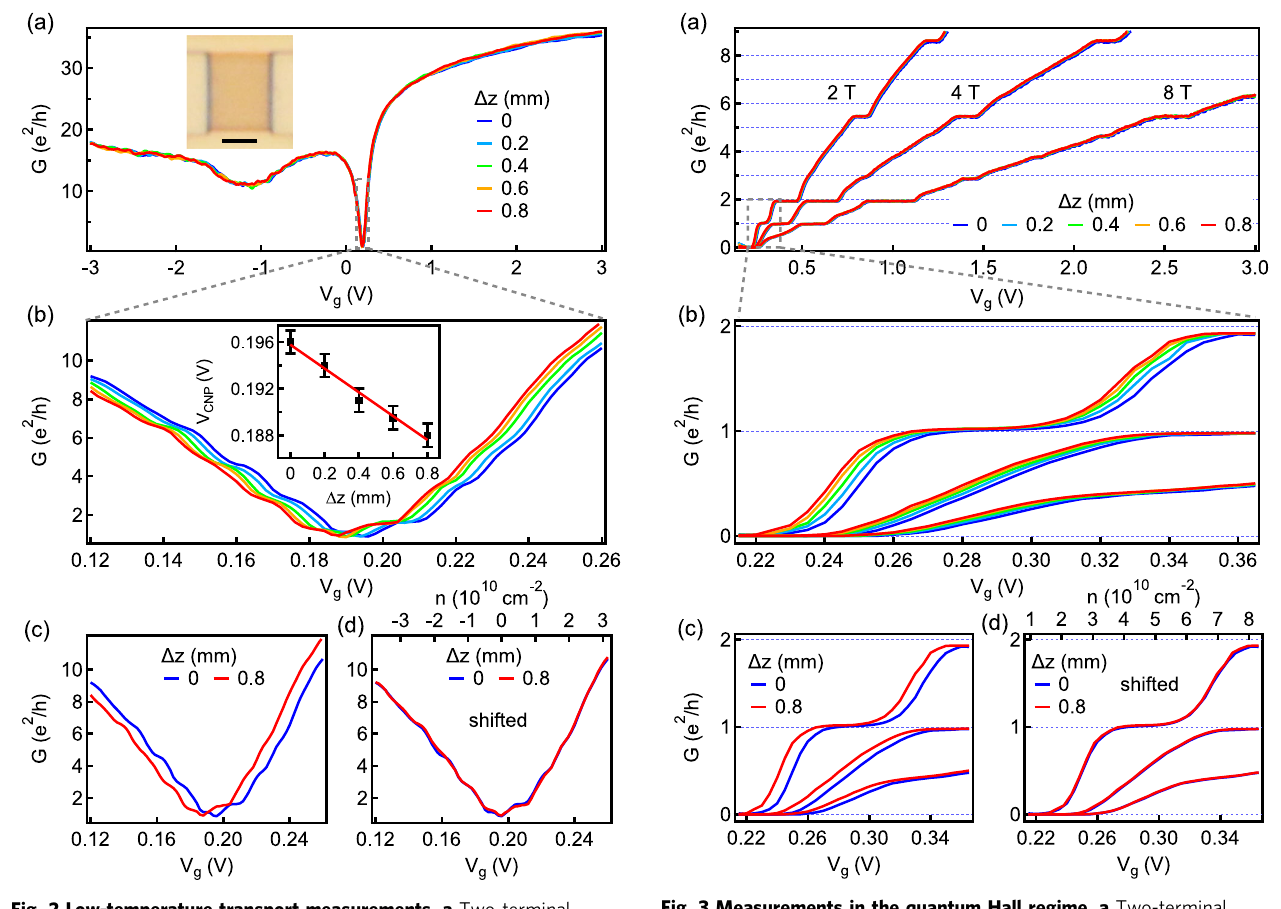
Fig. 2c the two curves with the lowest ( Δ z = 0) and the highest ( Δ z = 0.8 mm) strain values, and in Fig. 2d the same data, but with the Δ z = 0.8 mm curve (red) shifted by + 8 mV in V g . We fi nd that all conductance curves merge to the same curve as at Δ z = 0 (blue) when shifted by a constant gate voltage offset. This shift we attribute to a strain-induced scalar potential in the graphene sheet.